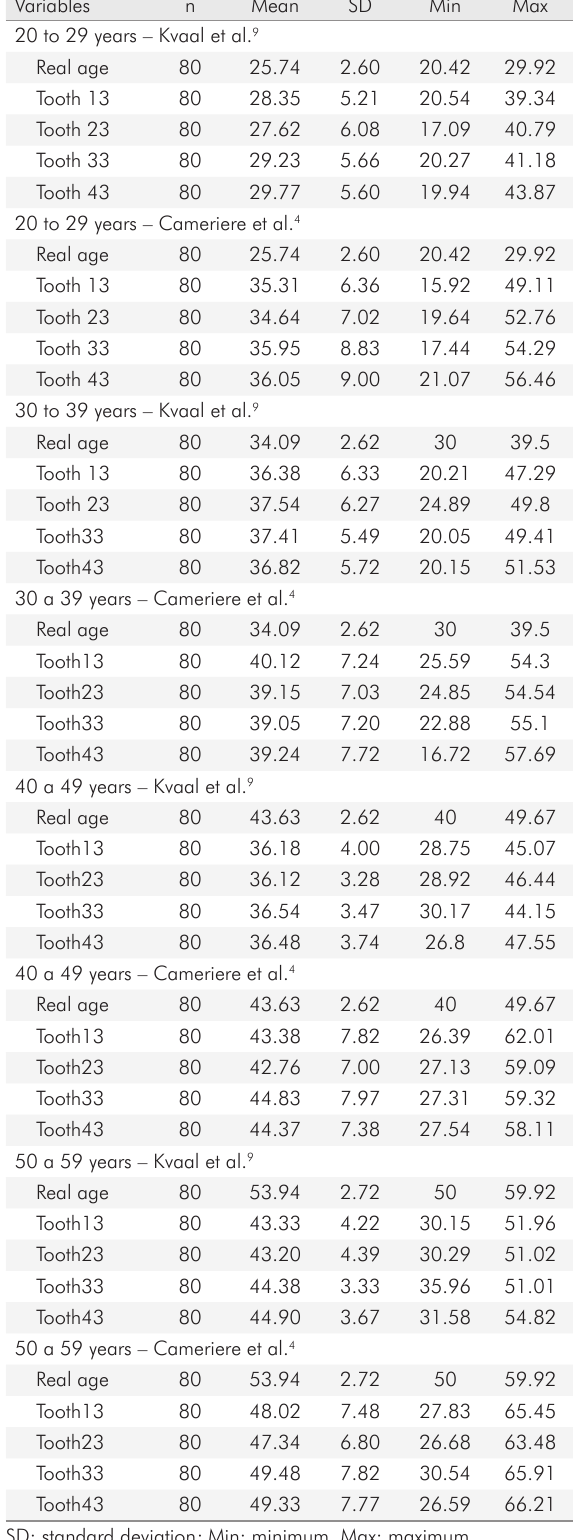
Table 2. Mean of real ages and estimated ages by